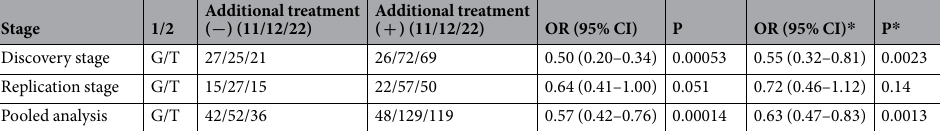
Table 2. Replication and pooled analysis of the association between ARMS2/HTRA1 rs10490924 and additional treatment requirement after 3 monthly injections of ranibizumab. * Adjusted for age and sex, OR: odds ratio, CI: confidence